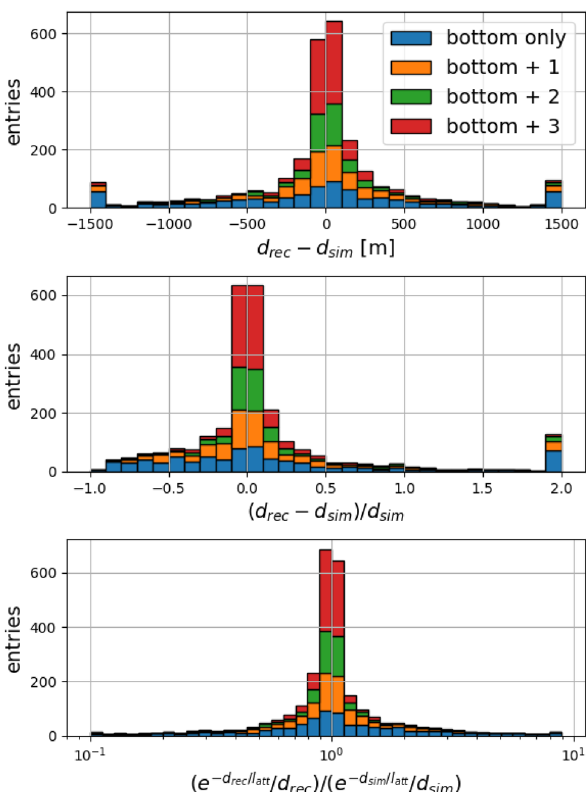
Fig. 8 Stacked histograms showing the performance of the vertex reconstruction method. Top: Difference between reconstructed and actualdistancebetweenshowerandstation.Middle:Relativeuncertain- ties on the reconstructed distance. Bottom: Ratio between the expected attenuation of the radio signal using the reconstructed and the actual distance to the shower. Events are divided into four categories: Those whereonlychannelsofthephasedarrayoronthehelperstringsdetected a signal with SNR > 2 . 5, and those where 1, 2, or 3 of the additional channels on the power string detected a signal with SNR > 2 . 5. The outermost bins in all plots are overflow bins